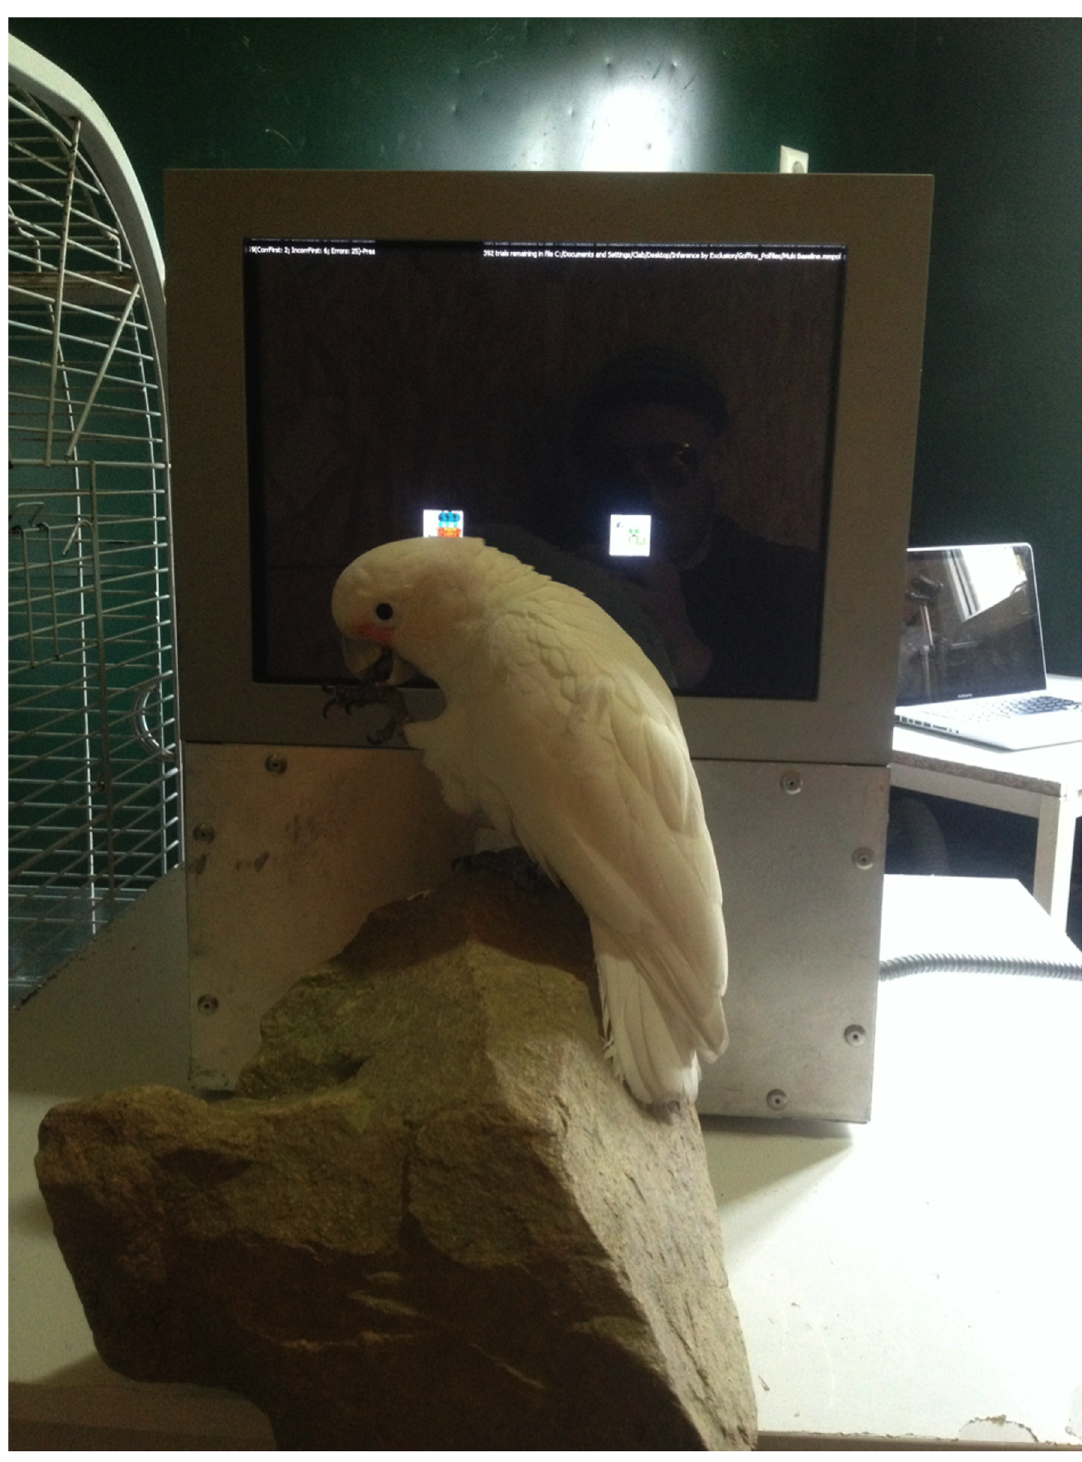
Fig 1. Experimental setup. Individual perching on the pedestal stone in front of the touch screen.